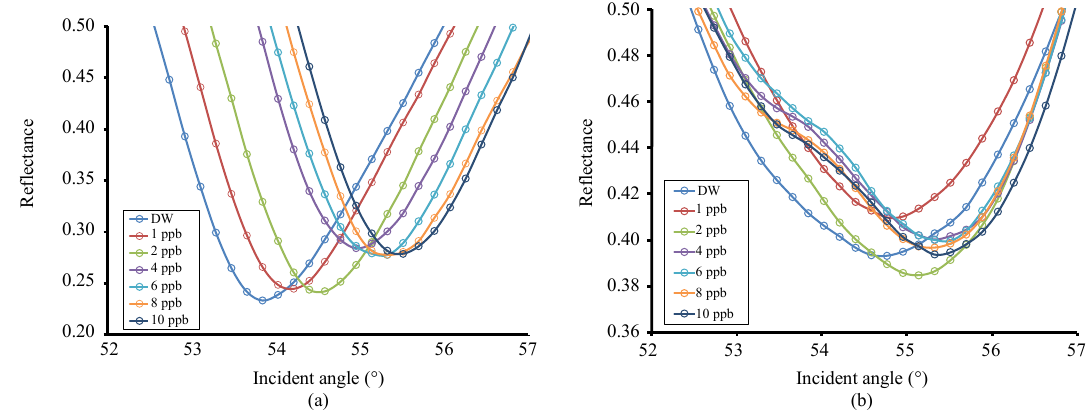
Fig. 5 Response curve of Fe 2 H 2 O 4 -SPR sensor when evaluated with (a) As(III) and (b) As(V) within the concentration range of 1 ppb – 10 ppb. DW: deionized water.